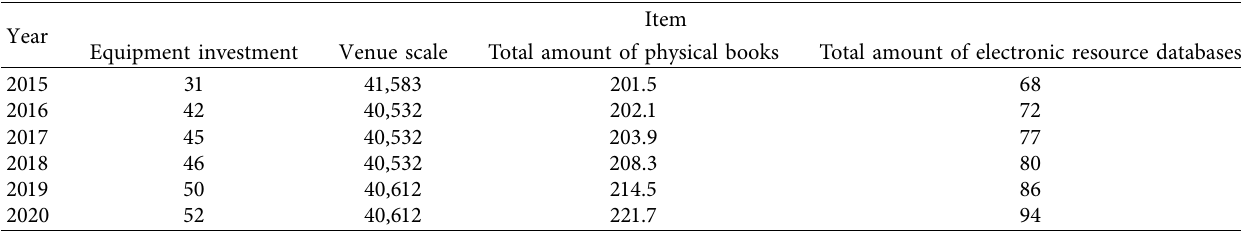
Table 3: Material cost of libraries in 2015–2020.